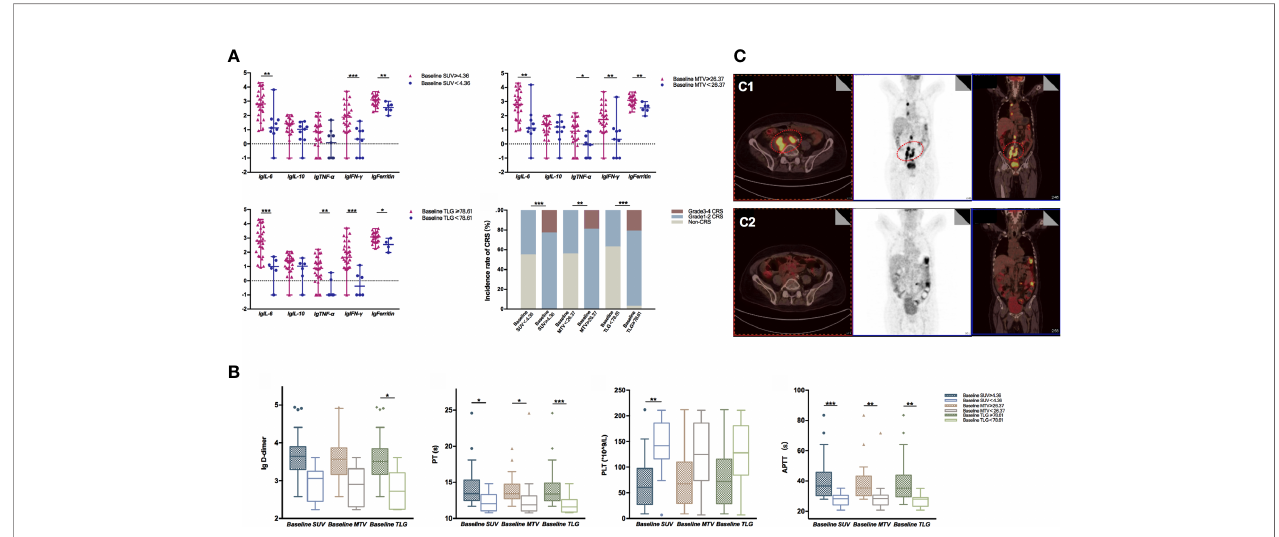
FIGURE 3 | (A) lg (peak serum cytokine level) between different groups de fi ned by the optimal cutoff values of baseline MTV, TLG, and SUV were compared using the Mann – Whitney U test. Data were described as median (range). High baseline SUV, MTV, and TLG group had signi fi cantly increased lg (peak serum cytokine level) than the compared groups; groups with baseline SUV ≥ 4.36 ( p < 0.001), MTV ≥ 26.37 ( p = 0.001), and TLG ≥ 78.61 ( p < 0.001) had a higher incidence of severe CRS than the compared groups. (B) Indicators associated with coagulation function between different groups de fi ned by the optimal cutoff value of baseline MTV, TLG, and SUV were compared using the Mann – Whitney U test. Data were described as median (95% CI). Groups with baseline TLG ≥ 78.61 had signi fi cantly higher lg (peak D-dimer) than the compared group (P = 0.040); groups with baseline PET/CT metabolic parameters greater than or equal to the cutoff value had prolonged APTT and PT; the group with baseline SUV < 4.36 had higher PLT than the baseline SUV ≥ 4.36 group ( p = 0.002). (C) Typical radiographic changes of PET/CT in a DLBCL patient after CAR-T cell therapy. (C1) Prior to CAR-T cell therapy, lymphoma cells involved in the abdominal aorta, right iliac vessels, as well as mediastinum exhibited high metabolic activity in FDG PET/CT; (C2) One month post CAR-T cell infusion, the metabolic activity of the abdominal aorta and right iliac vessels decreased signi fi cantly. *0.01 ≤ P < 0.05, **0.001 ≤ P < 0.01, ***P <